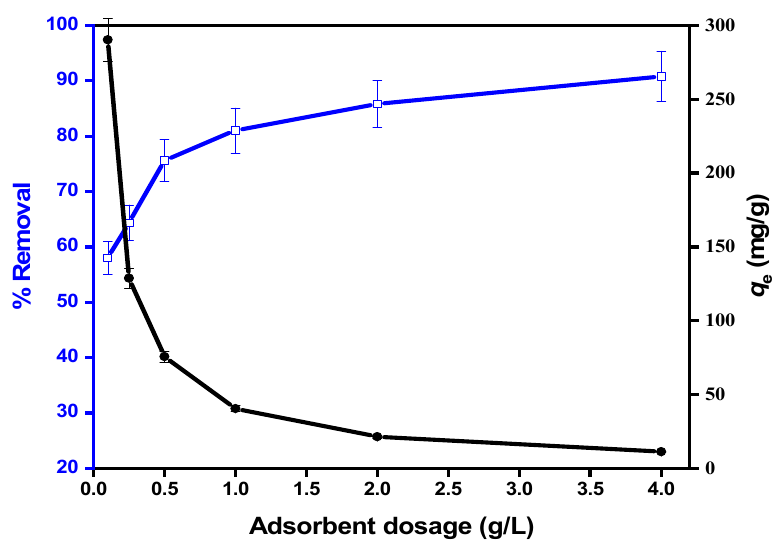
Figure 8. Effect of MIP-202/CA composite beads dosage on diazinon removal at pH = 7, contact time = 40 min, temperature = 22 °C, agitation speed = 300 rpm, and initial diazinon concentration of 50 mg/L.